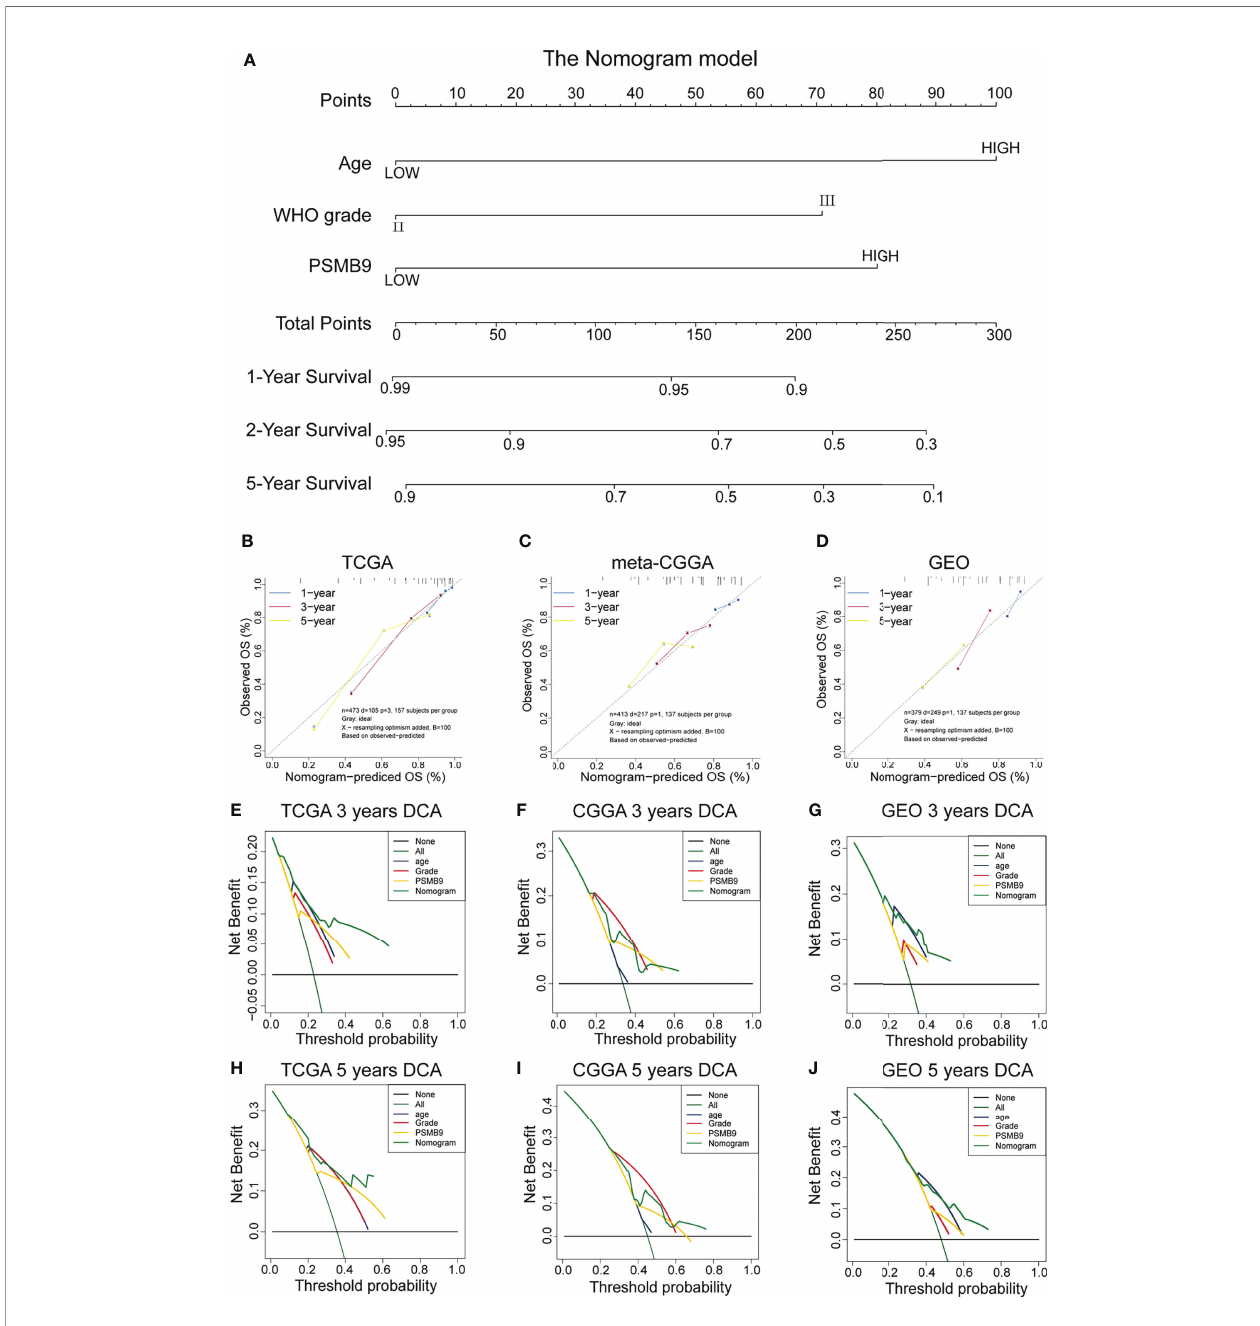
FIGURE 5 | Construction and validation of the nomogram model. (A) Construction of Nomogram Model about clinical features (including WHO Grade, IDH Status, IDH 1p19q and MGMT) in patients with low-grade glioma. (B – D) The 1/3/5-year OS calibration curves verify the prediction accuracy of the PSMB9-based nomogram model in the TCGA(B), meta-CGGA (C) and GEO (D) LGG cohorts. (E – J) Decision Curves Analysis (DCA) construction in TCGA (E, H) , meta-CGGA (F, I) and GEO (G, J)